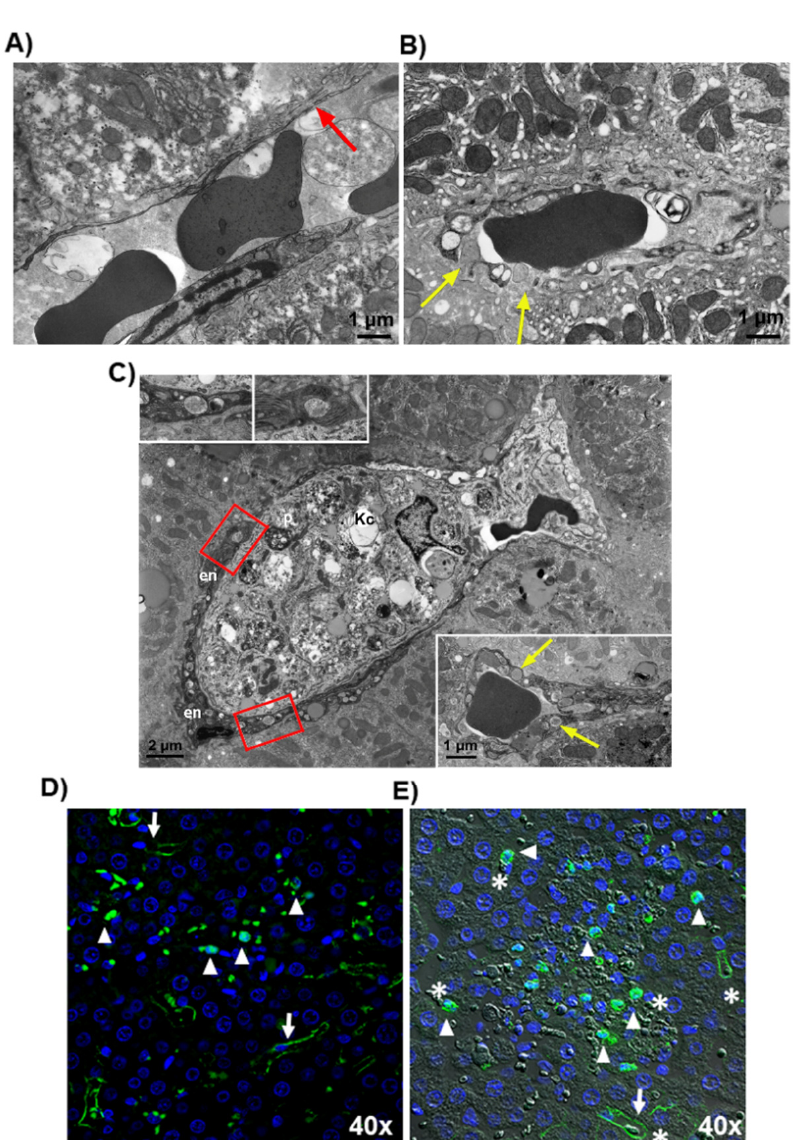
Figure 6. Representative rat liver from placebo group, saline-exposure: ( A ) a sinusoid with a physiologically discontinuous endothelium exhibiting a fenestration (red arrow) (transmission electron micrographs). Representative rat liver from placebo group, LPS exposure: ( B ) sinusoidal endothelium shows abnormally large fenestrations (yellow arrows) (transmission electron micrographs); ( C ) large Kupffer cell (Kc), completely occluding the sinusoid, that contains irregularly shaped phagosomes ( p ), red blood cell fragments and digestive debris. Note that endothelial cells (en) contain some electron-dense vacuoles, as shown in the boxed areas and enlarged in the insets in the upper part of the figure. Endothelial cells in the lower panel also exhibit electron-dense vacuoles (yellow arrows) (transmission electron micrographs); ( D ) TM was expressed in some endothelial cells lining liver sinusoids (arrows) or, more frequently, was shed forming rounded masses of the protein (arrow- heads) (Immunofluorescence analysis); ( E ) localization of functional TM that lines sinusoids having erythrocytes inside (arrows), while TM shedding was detected in sinusoids where the endothelial line was lost (arrowheads) (differential interference contrast). The identity of sinusoids was confirmed by observing the position of erythrocytes (asterisks) that can be easily identified using this technique. The staining with DAPI revealed that the TM immunoreactive masses localized in the sinusoids exhibited the nucleus, suggesting they likely underwent phagocytosis by sinusoidal Kupffer cells. Green: TM; blue: